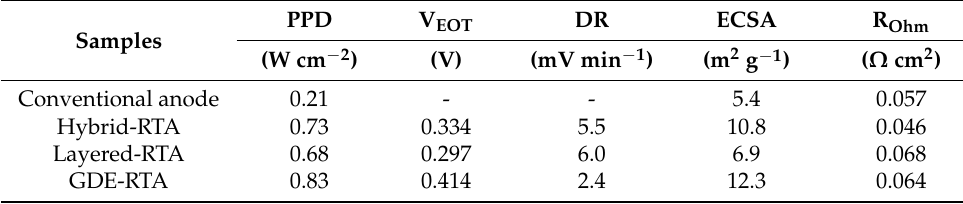
Table 3. Electrochemical data analysis and voltage decay rate of aged MEAs.